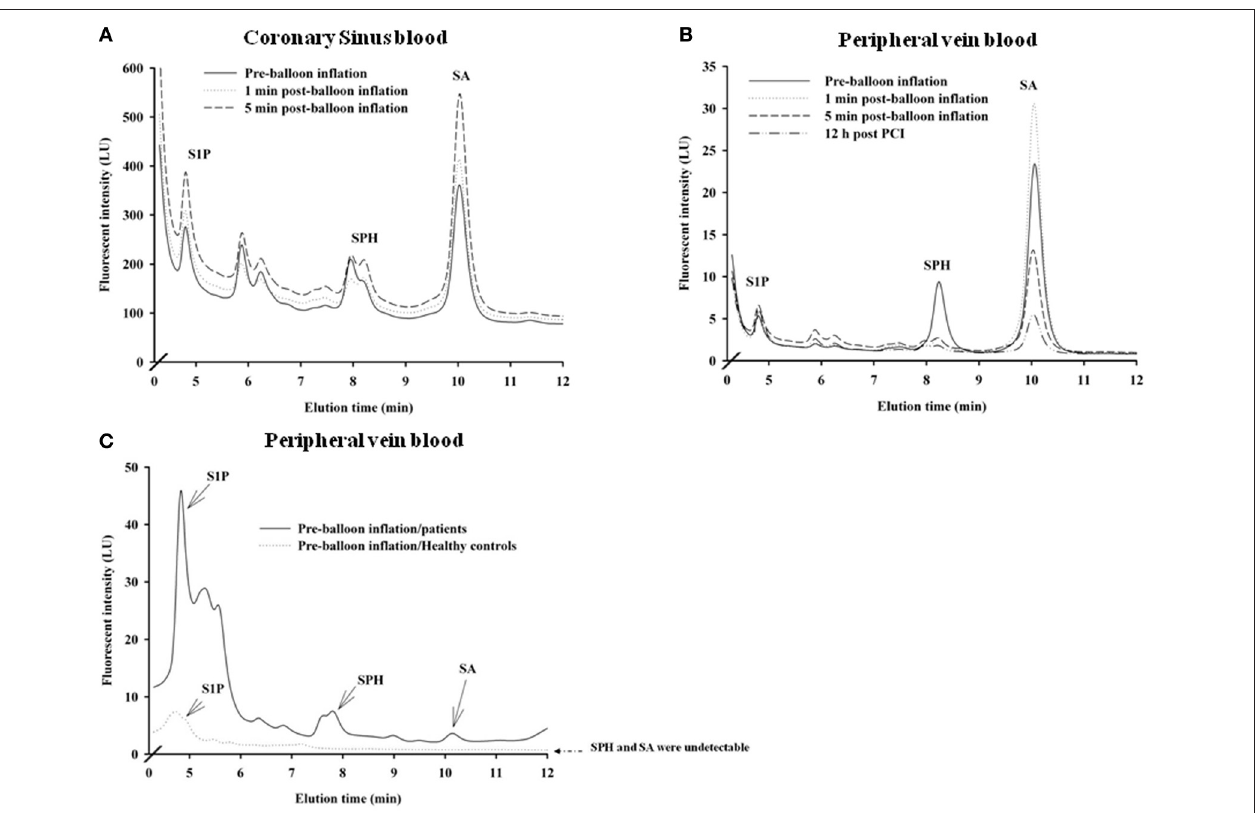
FIGURE 1 | Distribution of sphingolipids in coronary sinus blood (A; n = 7) and in peripheral blood (B; n = 24) in patients who underwent PCI. Also shown are comparative distributions of sphingolipids in peripheral blood at baseline (before balloon inflation in a